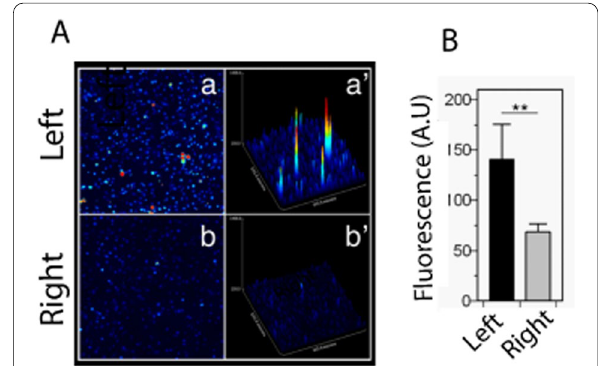
Fig. 3 L/R Ca 2 + concentration comparison. MDA-MB-231 cells treated with L/R normal breast extracts from donor W1 and measurement of intracellular calcium concentration with Fluo3 AM. A Representative calcium fluorescence in two-dimensional (a and b) and three-dimensional images-surface plot- (a ′ and b ′ ). Pseudo-color from black to red represents low to high intracellular calcium concentration, respectively. B Fluorescence quantification was performed on still images ( 20 magnification), by calculating × the fluorescence mean of 50–100 cells fields. The analysis reveals a significant increment of intracellular calcium concentration in the L-treated cells. Values represent the mean SEM from 3 independent ± experiments, 50–100 cells were analyzed per experiment (unpaired T-test with Welch’s correction, p < 0.003). A.U artificial